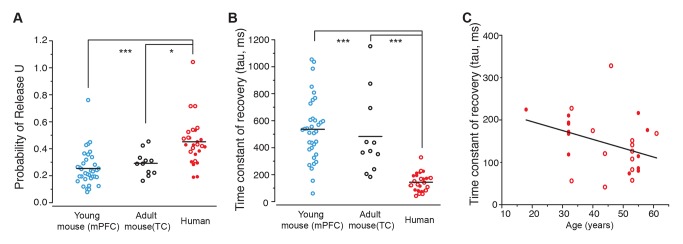
Tsodyks-Markram model for dynamic synapses.(A) Utilization of absolute synaptic efficacy (mean ± SEM), proportional to the probability of release. 0.45±0.03 in human (n = 27, 14 from tumor patients and 13 from epilepsy patients) versus 0.25±0.02 and 0.29±0.03 in young (n = 35) and adult mice (n = 11), respectively; p<0.001 and p<0.05. Filled red circles, human tumor patients; open red circles, human temporal lobe epilepsy patients. (B) Time constant of recovery from synaptic depression. 144±13 ms in human (n = 27, 14 from tumor patients and 13 from epilepsy patients) versus 536±40 ms and 483±91 ms in young (n = 35) and adult mice (n = 11), respectively; p<0.001 in both cases. (C) Time constant of recovery from synaptic depression did not change with age during adulthood. No correlation in the data was found, as indicated by the Pearson's correlation coefficient rho = −0.36, p = 0.1. (Data deposited in the Dryad repository, http://doi.org/10.5061/dryad.3723p
[56]: Raw data of human and rodent EPSPs in 30 Hz_EPSPs.rar; Numerical data that generated (A–C) in Data S2).